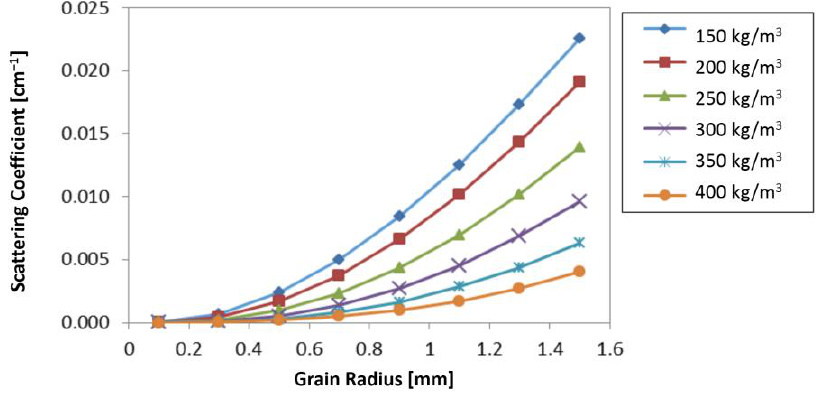
Figure 5. Cont. Figure 5.